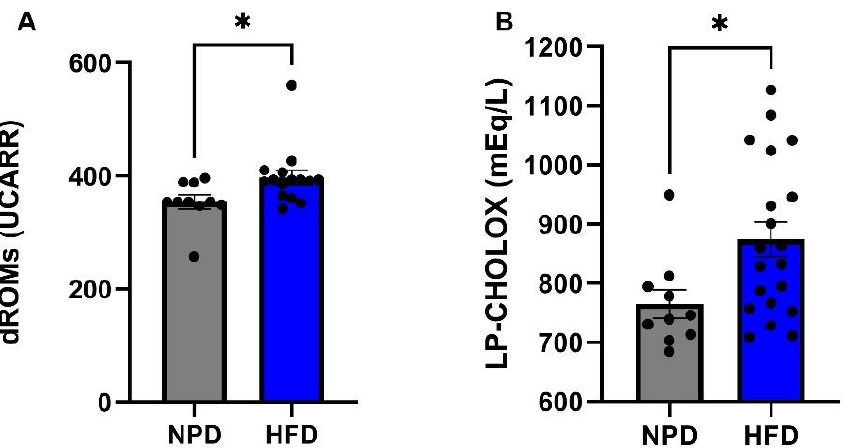
Figure 6. Pro-oxidant status in NPD and HFD experimental groups after 8 weeks (T1) of HFD. ( A ) dROMs Test. Differences in ROMs (primarily hydroperoxides) levels (UCARR) between NPD and HFD groups after 8 weeks of HFD. ( B ) LP-CHOLOX Test. Differences in LP-CHOLOX (lipoperoxides and oxidized cholesterol) levels (mEq/L) between NPD and HFD groups after 8 weeks of HFD. Statistical significance for (*) p < 0.05.